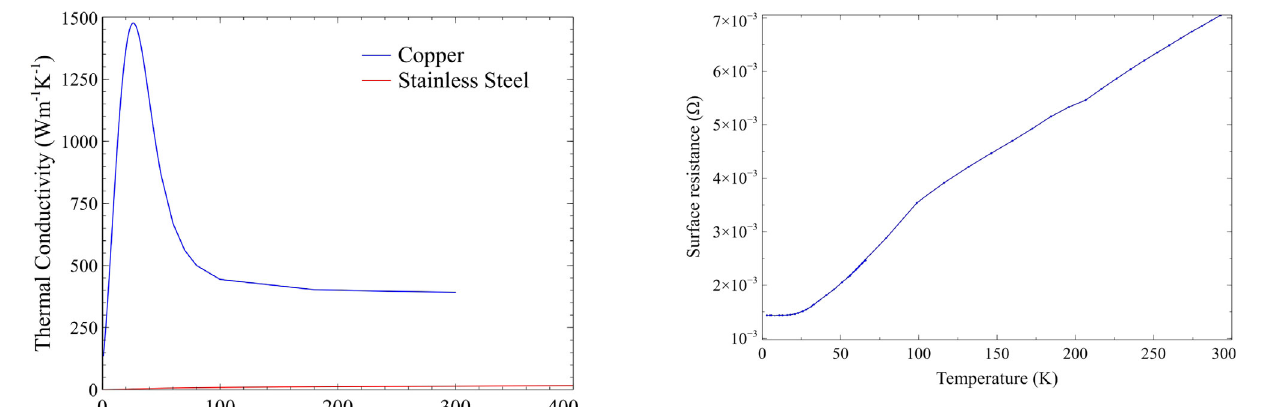
FIG. 4. Variation of surface resistance of copper with